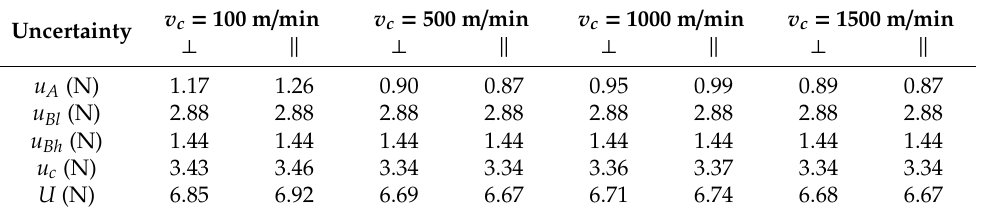
Table 6. Uncertainty and its components for EN AW-2024 T351, perpendicular and parallel milling direction in relation to the rolling direction as well as a p = 0.4